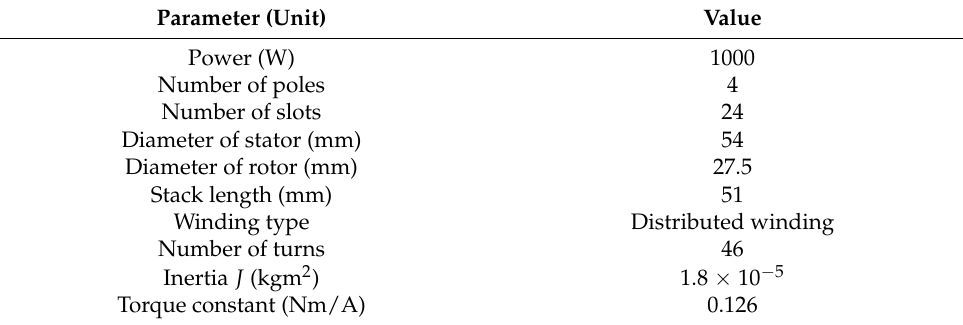
Table 1. Specifications of the selected IPMSM model.